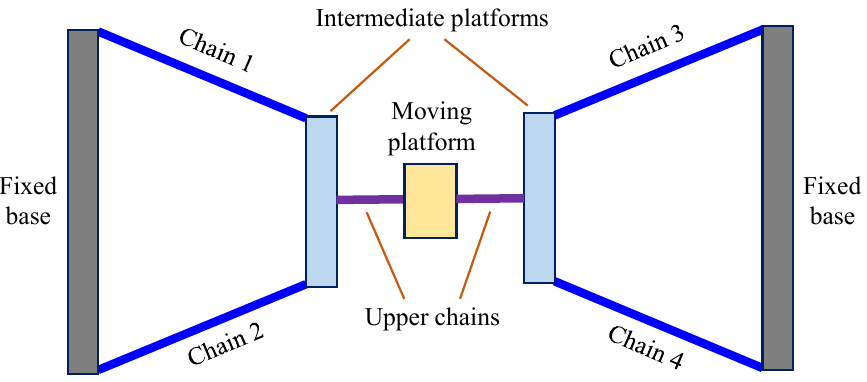
Figure 1. Topological structure of a non ‐ overconstrained 4 ‐ DOF PM.